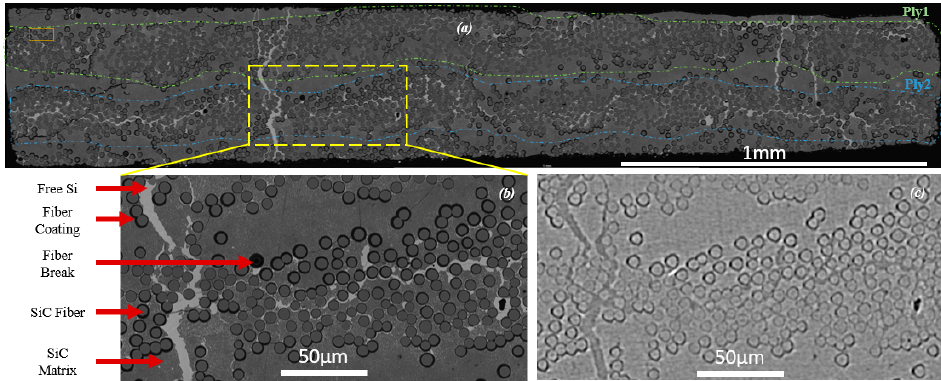
Figure 1. ( a ) Optical image of cross-section of test specimen. ( b ) Enlargement of area indicated in ( a ). ( c ) CT image slice from same area as in ( b ). The CT image was obtained before the test specimen was loaded to failure, whereas the optical image was obtained after failure. Damage that occurred during loading after the CT image was obtained can be seen in ( a , b ): gaps (black filled circles) remaining where fibers broke at locations coinciding with the plane of the cross-section and cracks normal to the plane of the cross-section near the left end of the image in ( a ).